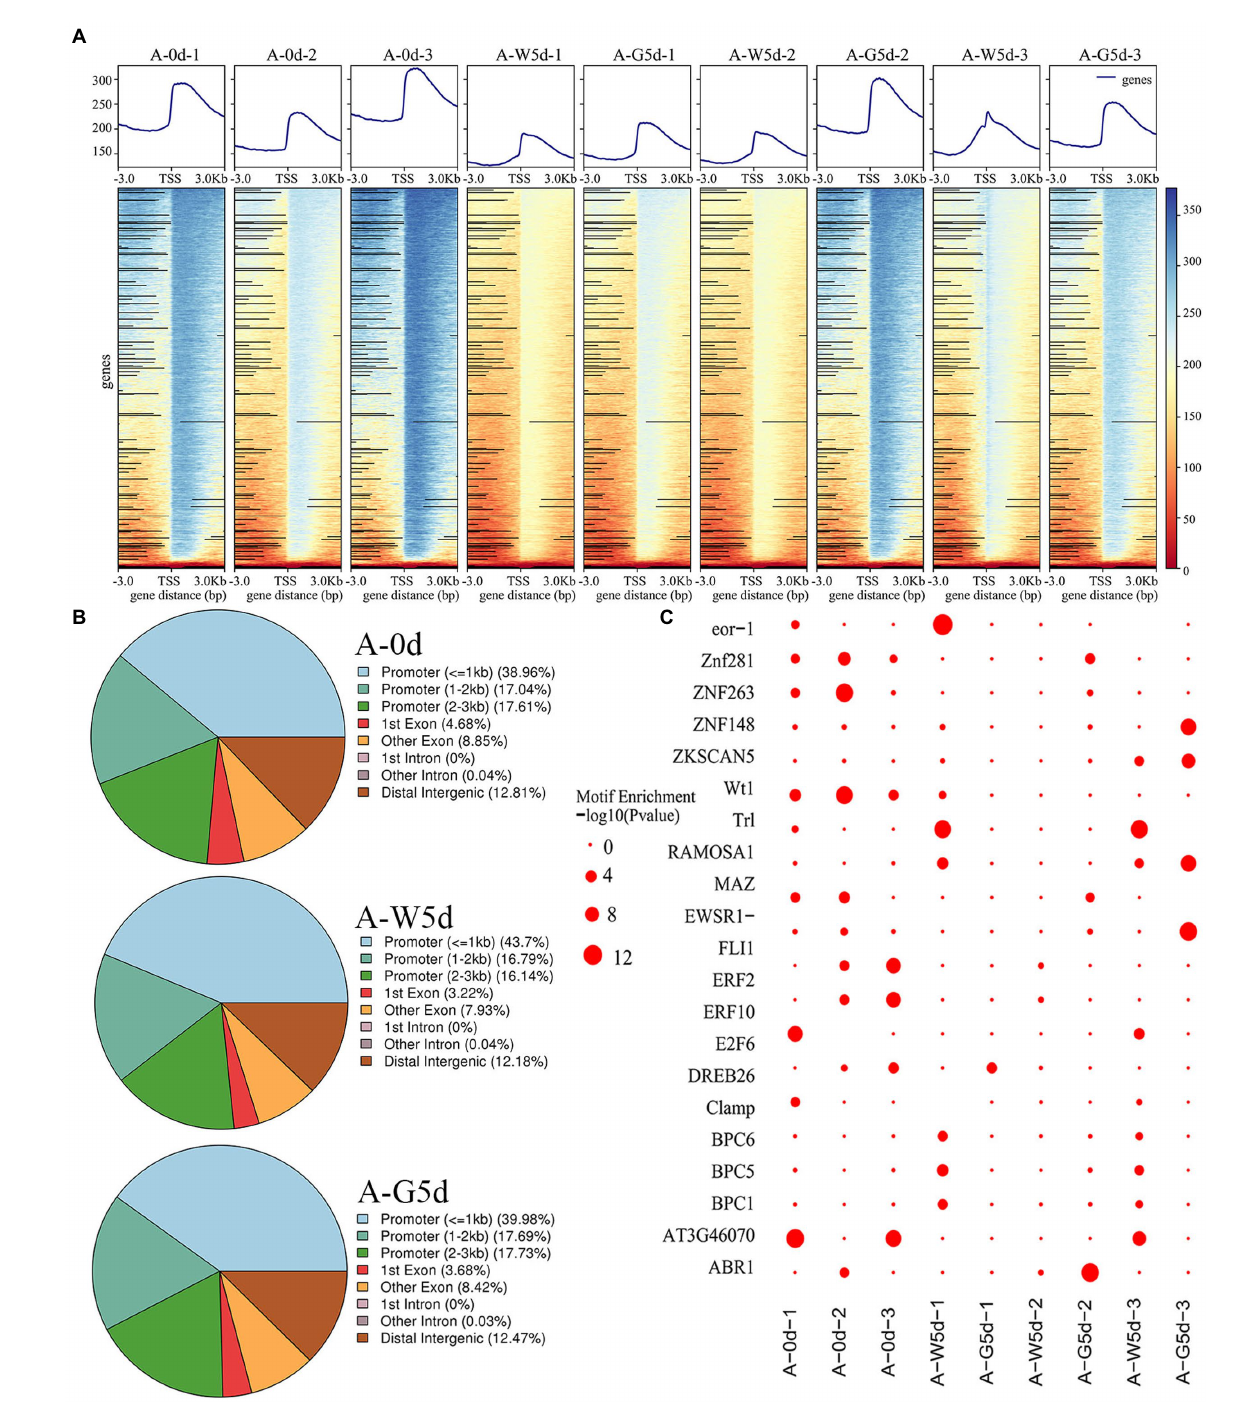
(Figure 3A). In the comparison of A-0d vs. A-W5d, genome-wide functional regions of DARs were mainly divided into promoter and distal intergenic with 35.14% promoter ( ≤ 1 kb) and 51.35% promoter (1–2 kb) (Figure 3B). Functional distribution of DARs-associated genes showed that they were mainly enriched in regulation of transcription (GO:0006355), positive regulation of GTPase activity